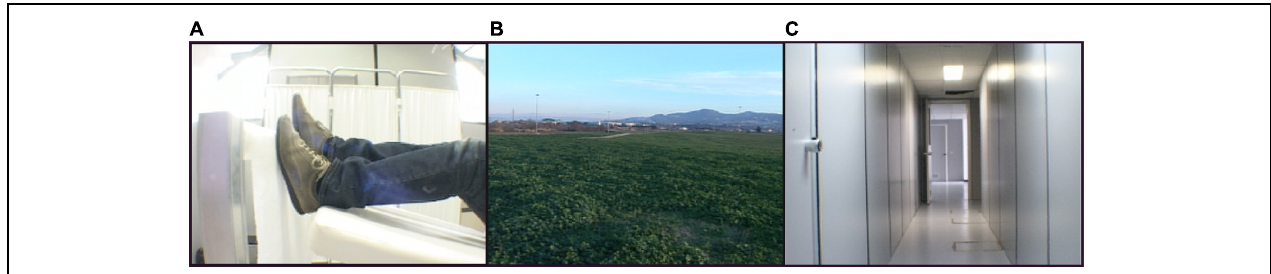
FIGURE 1 | Stimuli. (A) A still frame taken from the video clip showing an individual lying supine and walking on a rolling cylinder. (B) A still frame taken from the video clip showing a countryside view (open space). (C) A still frame taken from the video clip showing a corridor (narrow space).